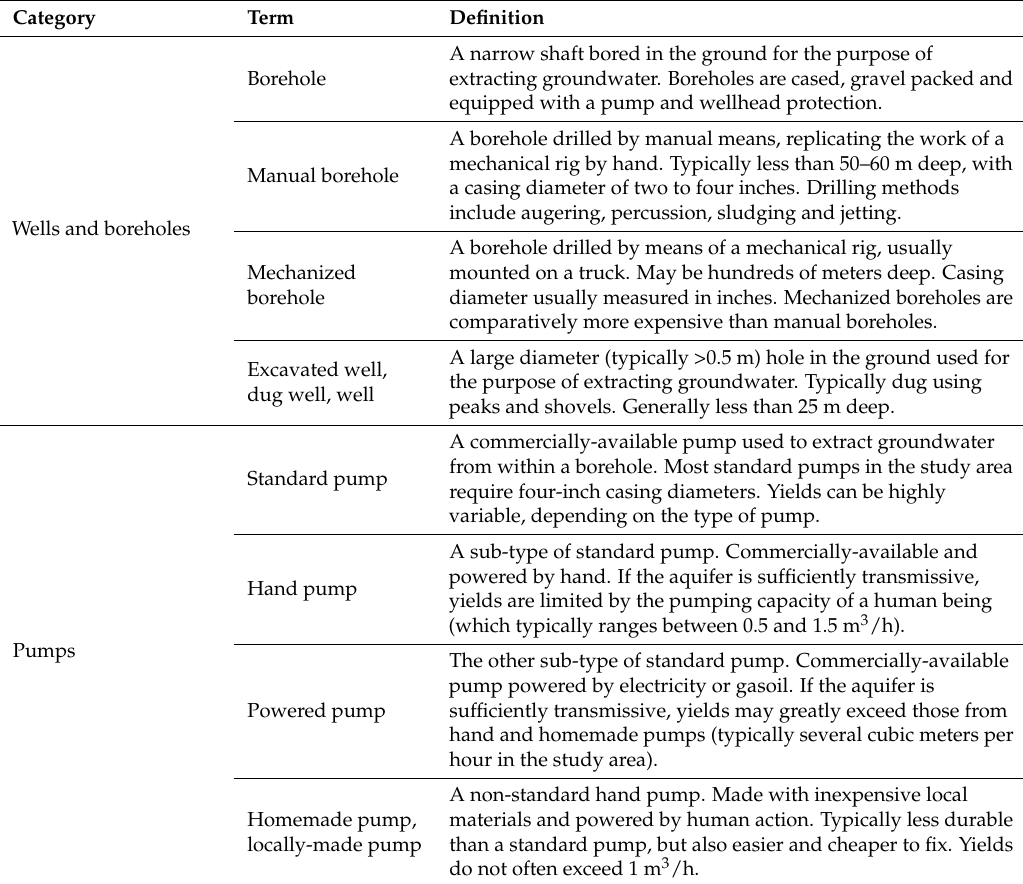
Table 1. Terminologies used in the